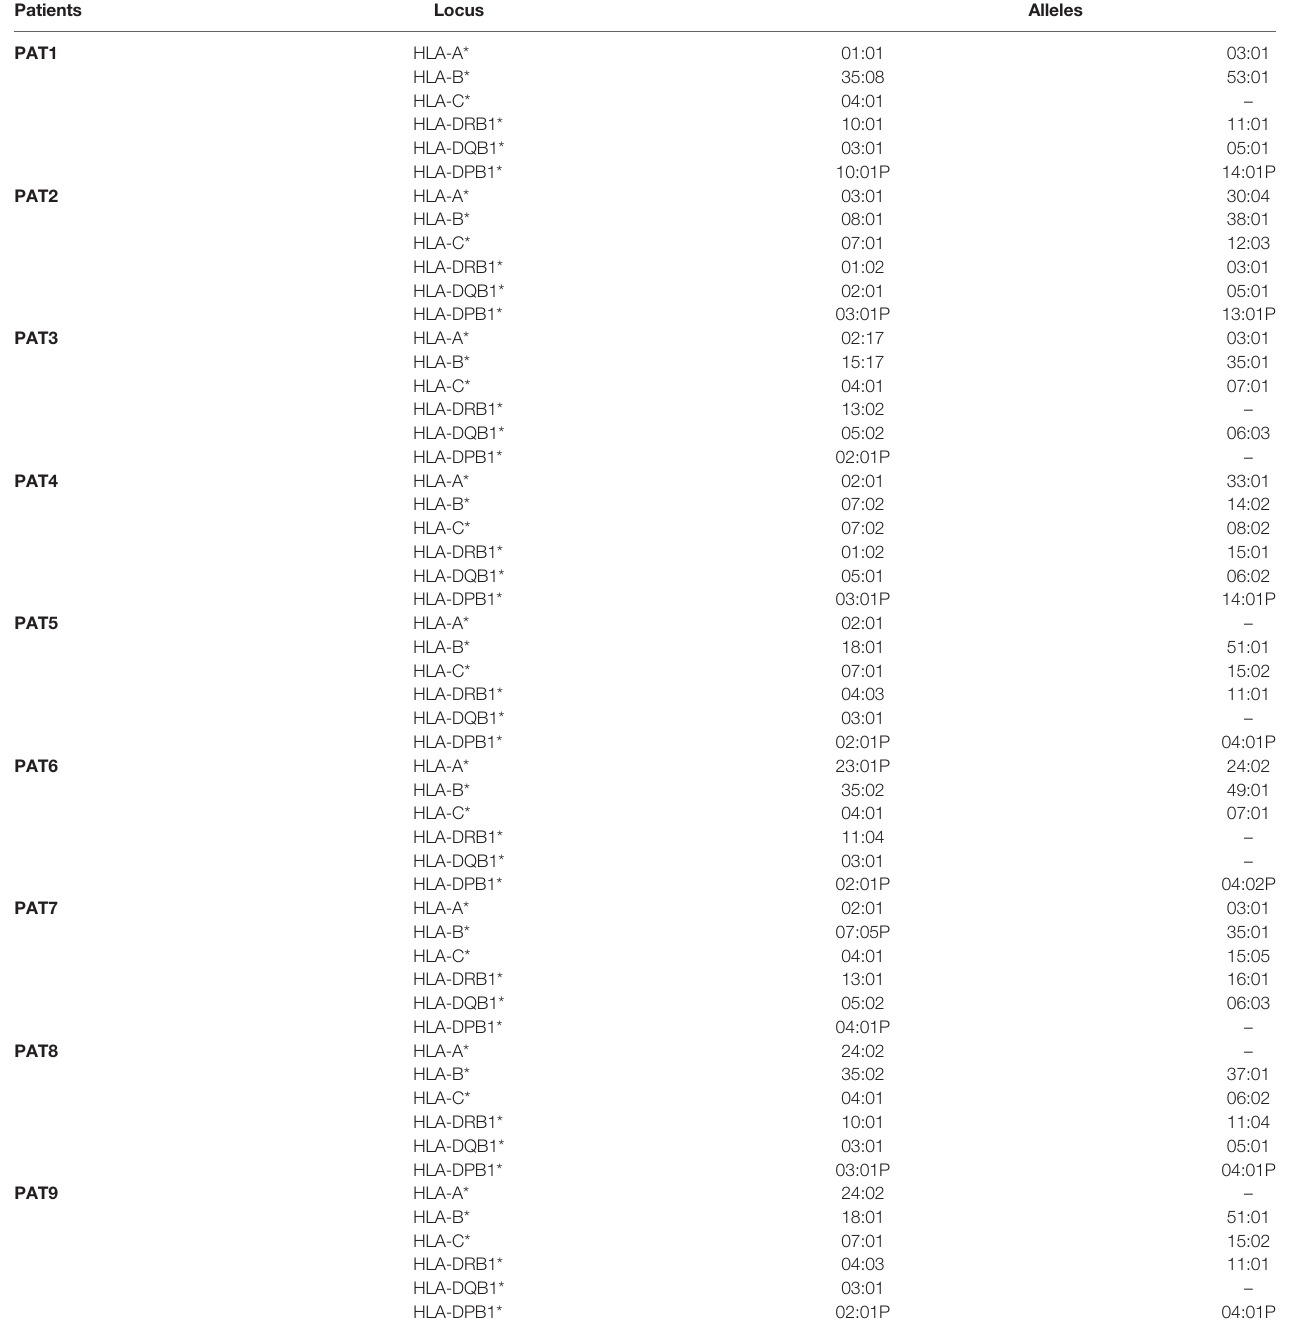
TABLE 5 | HLA haplotypes of oligometastatic